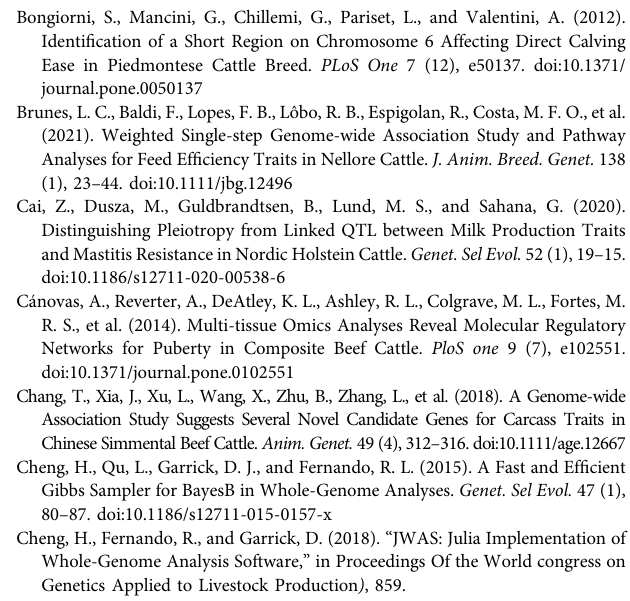
Supplementary Figure S1 | Location of 10 carcass primal cut yields in Hanwoo